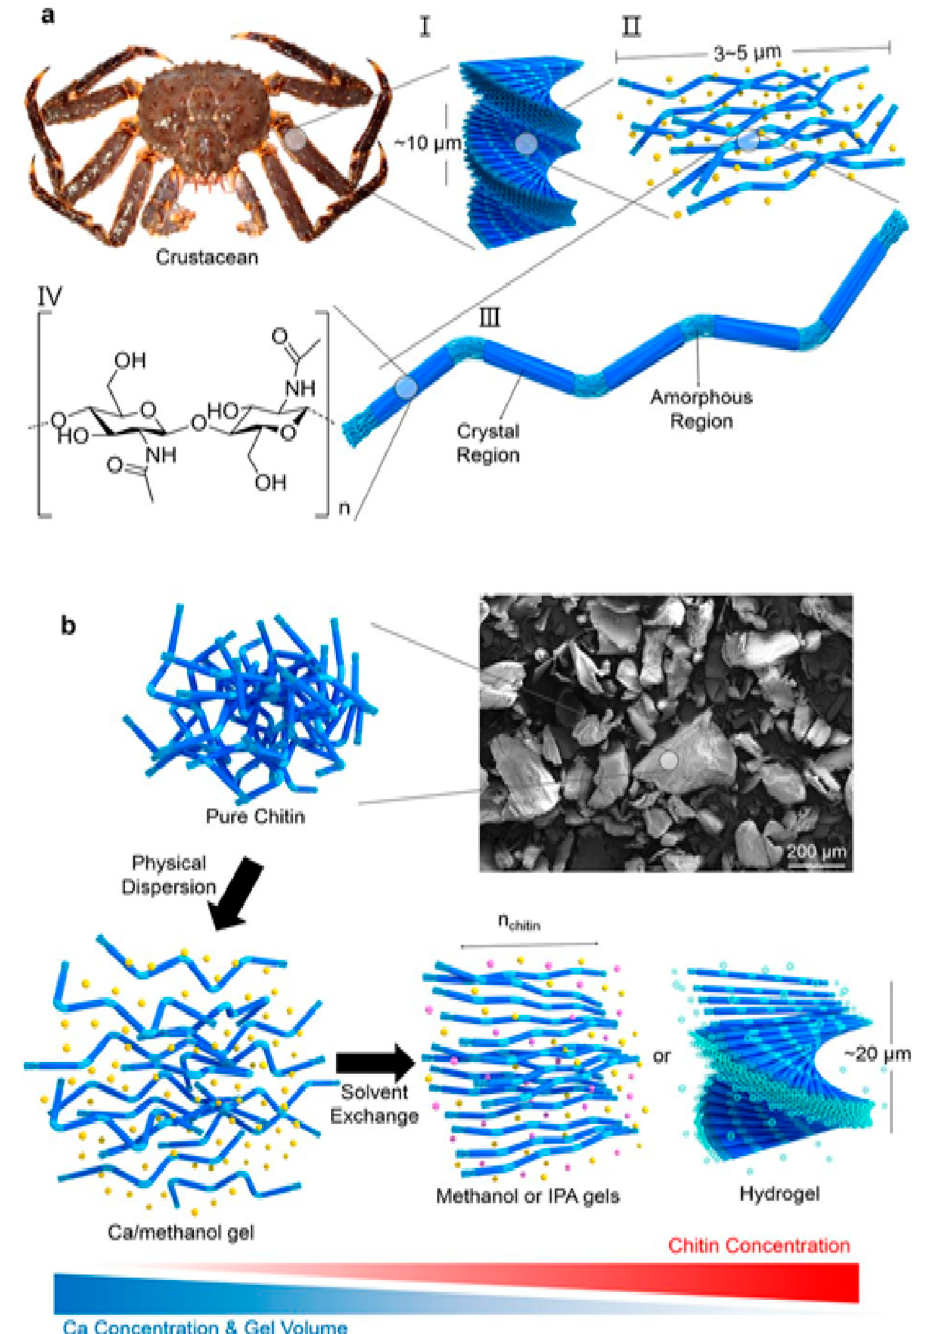
Figure 9. Crystallin and amorfous structure of chitin (courtesy of Oh et al. [29]).